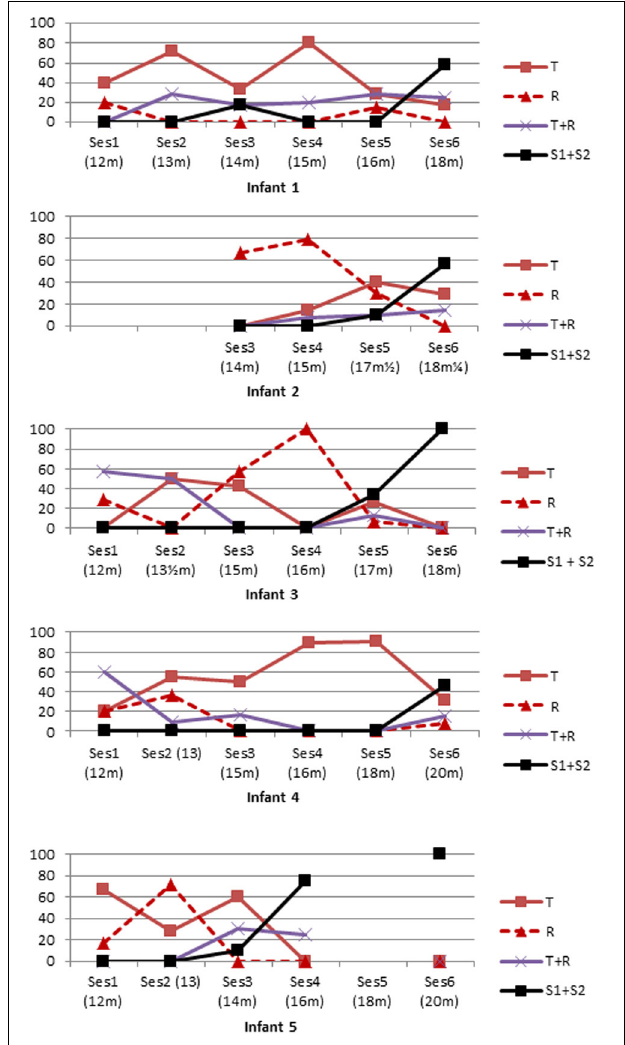
FIGURE 8 | Mean score on trial before and after demonstration in